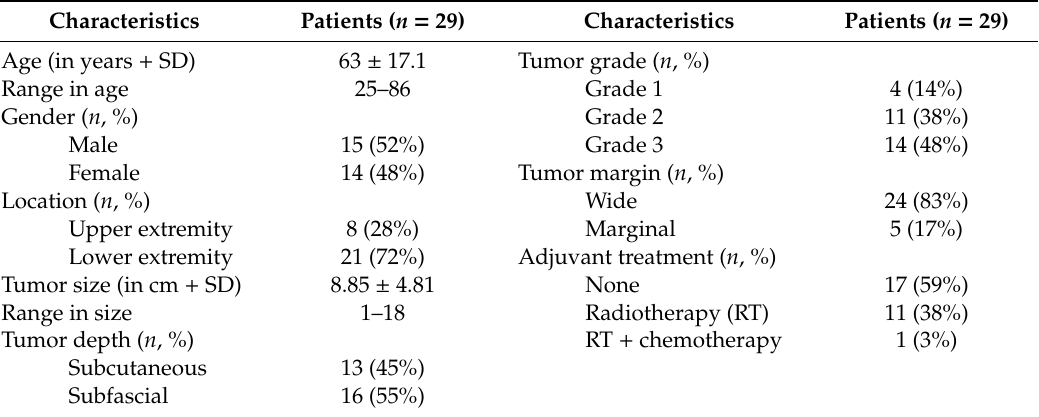
Table 1. Baseline characteristics of the